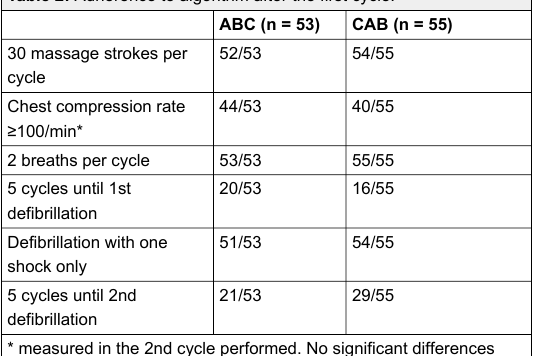
Table 2: Adherence to algorithm after the first